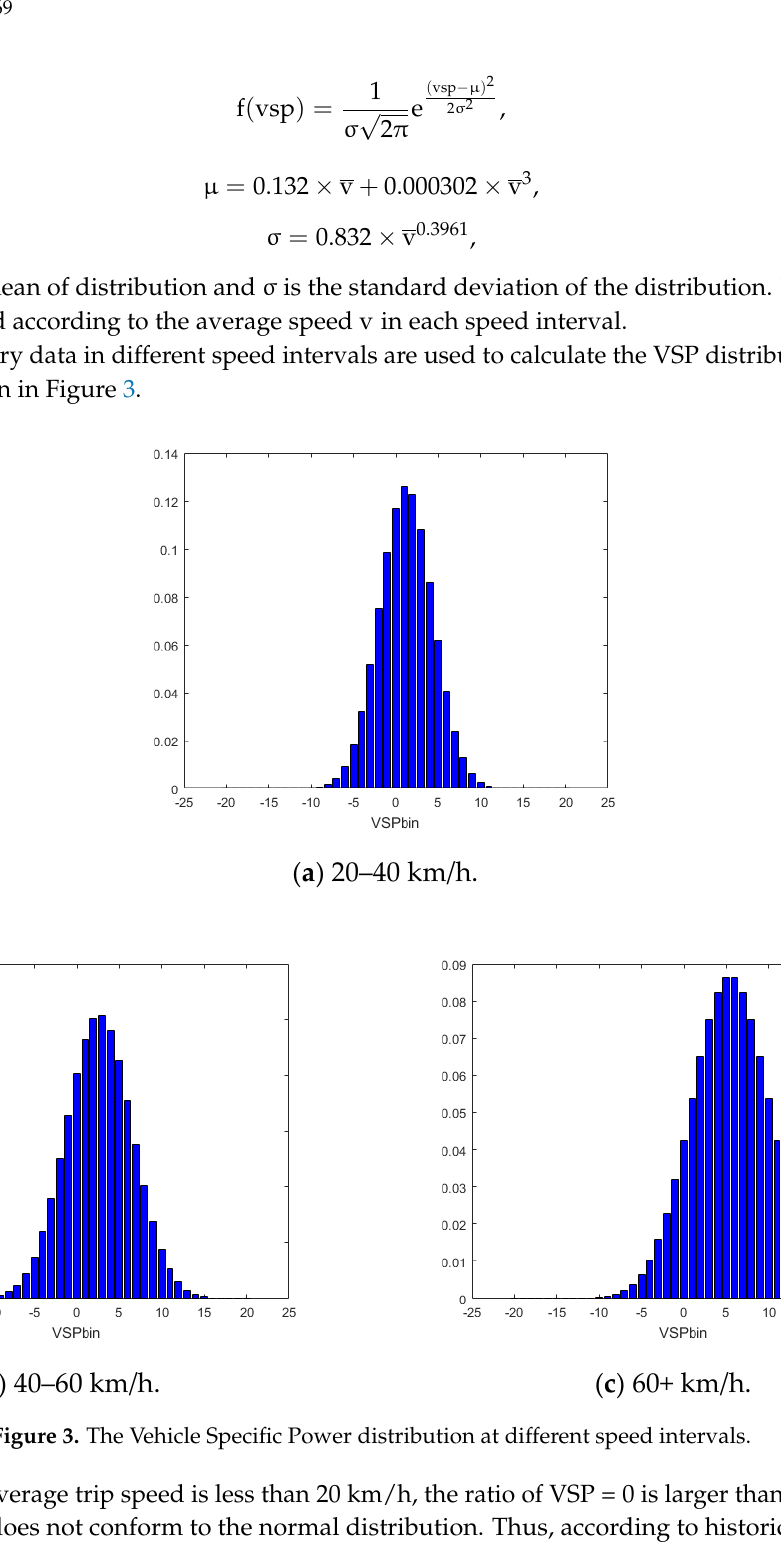
Figure 4. The Vehicle Specific Power distribution in the speed interval under 20 km/h.